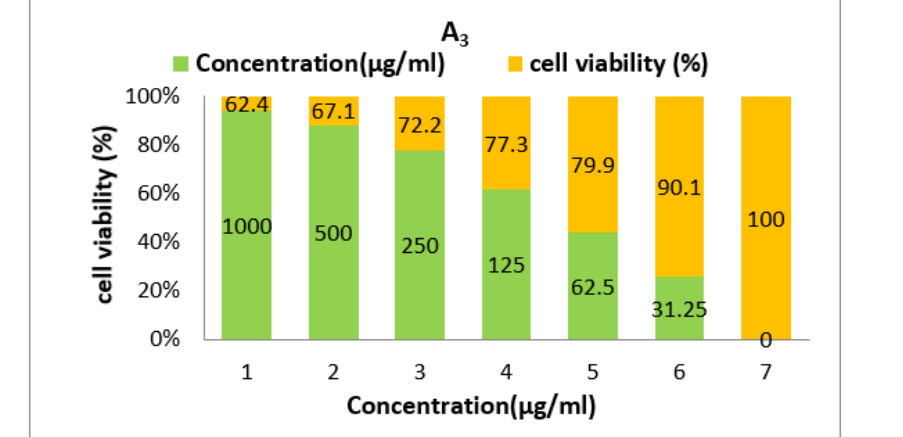
Fig. 13. The relationship of the percentage of inhibition with the concentration of (A 3